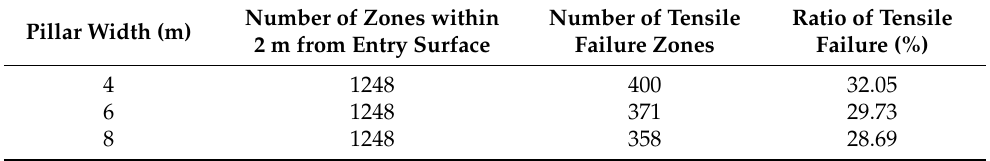
Table 3. Tensile failure ratio of surrounding rock in goaf excavation with different yield pillar widths.